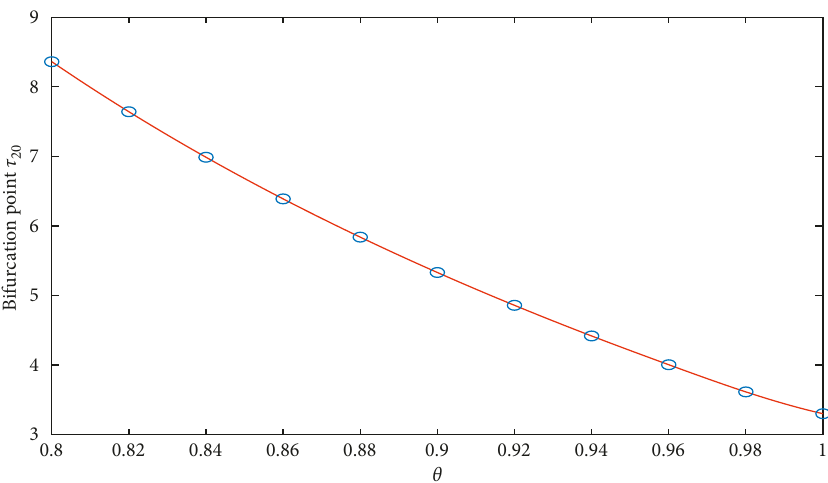
Figure 10: Case 5: effect of θ on bifurcation point τ